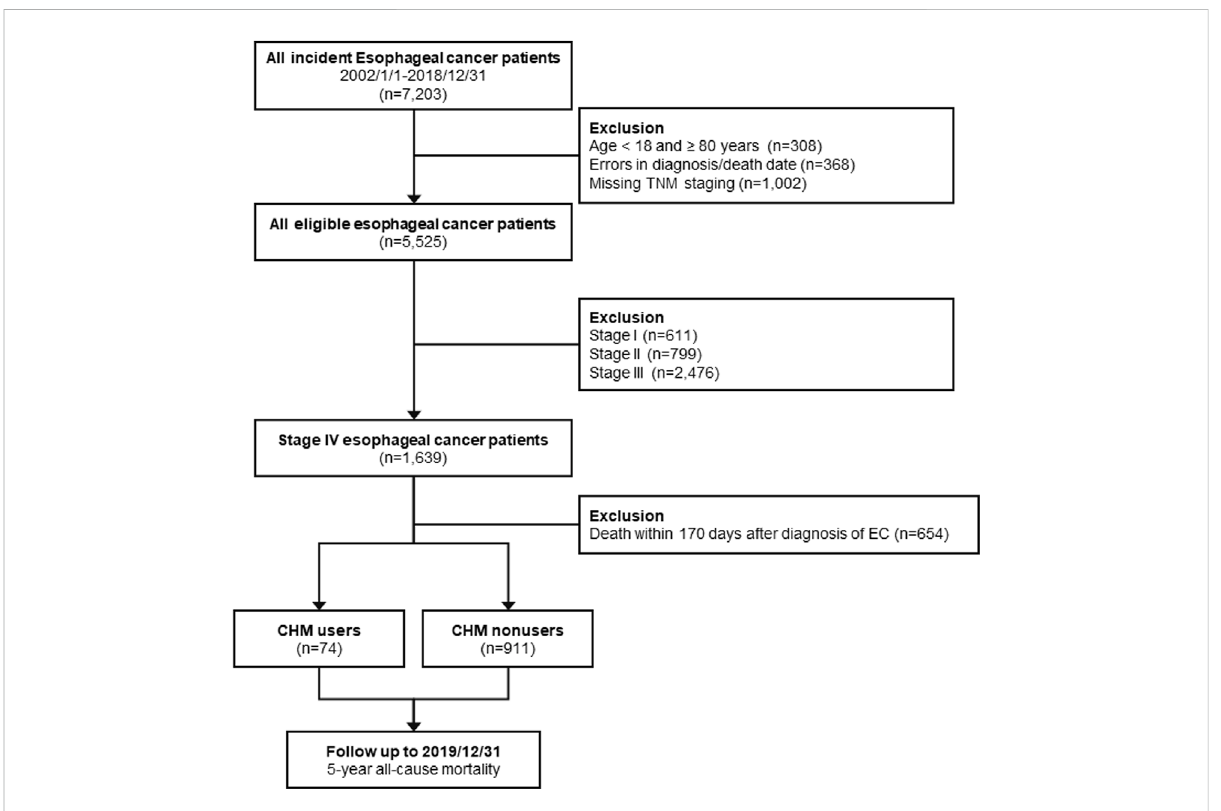
FIGURE 1 Flow chart of study design and selection procedure of study